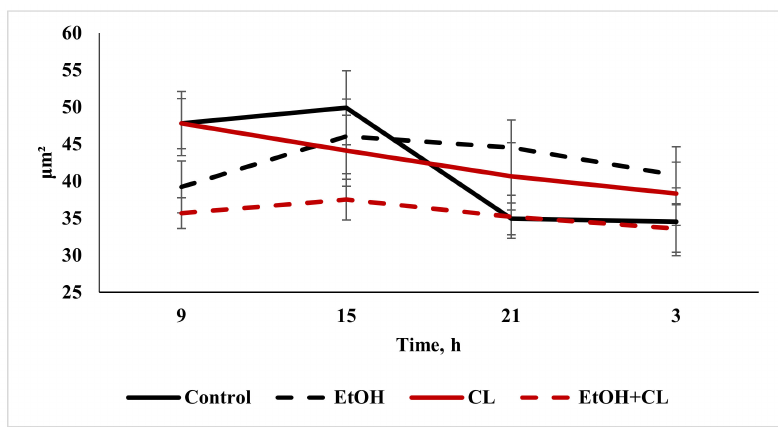
Figure 4. Daily dynamics of area of nuclei of hepatocytes of